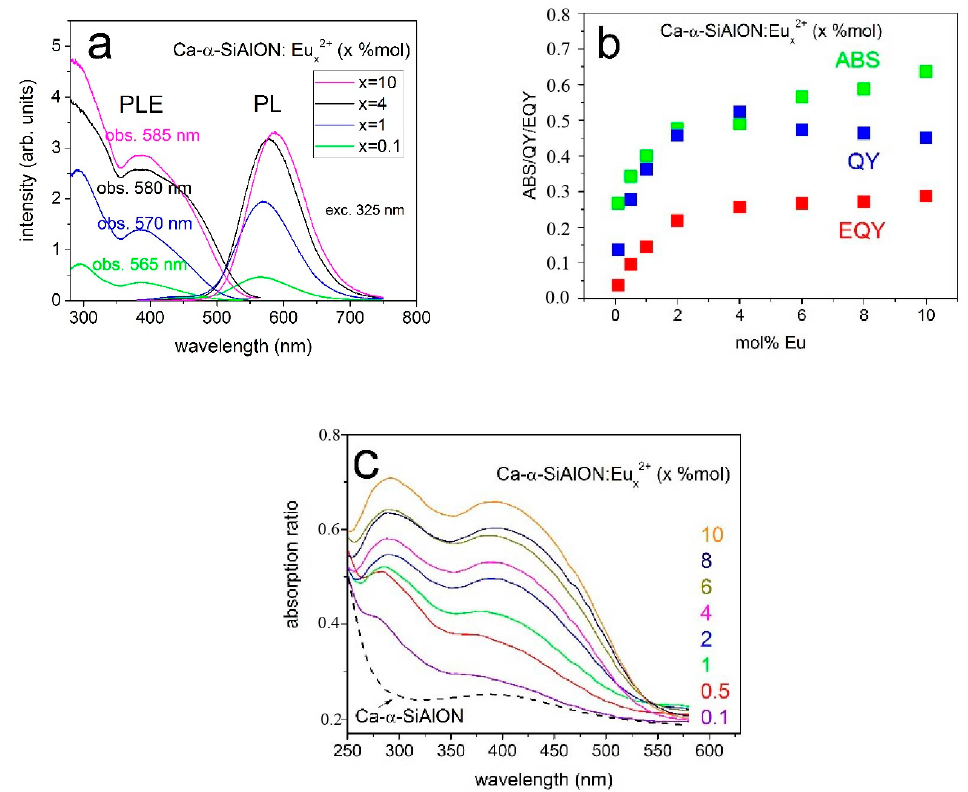
Figure 4. ( a ) Room temperature photoluminescence (PL) spectra of Ca 0.8 Si 9.6 Al 2.4 O 0.8 N 15.2 :xEu 2+ x [mol %] excited at 325 nm. Photoluminescence excitation (PLE) spectra of Ca 0.8 Si 9.6 Al 2.4 O 0.8 N 15.2 :xEu 2+ observed at the maximum of luminescence band. ( b ) Quantum yield (QY), absorption efficiency (ABS) and external quantum yield (EQY) of Ca 0.8 Si 9.6 Al 2.4 O 0.8 N 15.2 :xEu 2+ obtained under 420 nm excitation. ( c ) absorption spectra of Ca 0.8 Si 9.6 Al 2.4 O 0.8 N 15.2 :xEu 2+ .